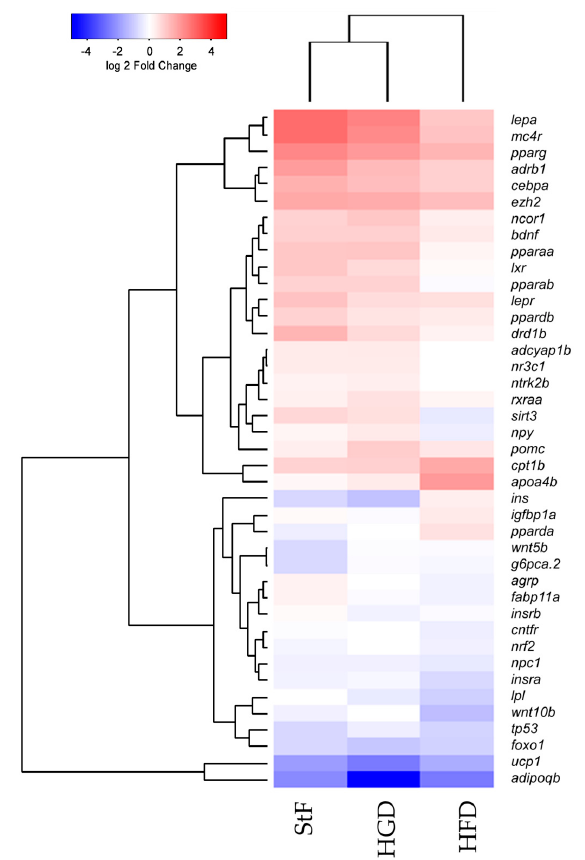
Figure 6. Hierarchical clustering of gene expression of genes involved in adipogenesis and adipose-gut-brain pathway. Comparison of gene expression at 15 dpf between samples of standard feed (StF), high glucose diet (HGD) and high fat diet (HFD) groups (Euclidean distance), normalized to the 6 dpf control.